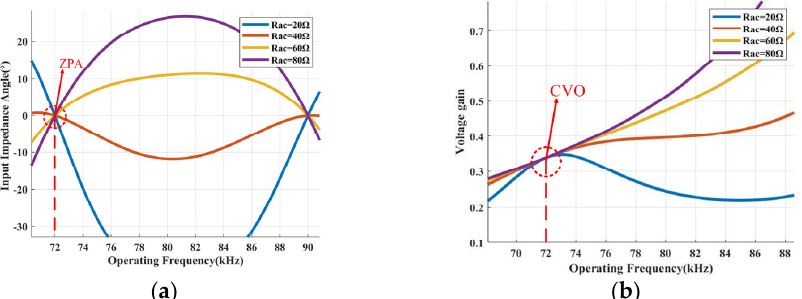
Figure 8. Voltage gain and input impedance angle of the proposed LC/S compensated IPT system. ( a ) Input Impedance Angle; ( b ) Voltage gain.